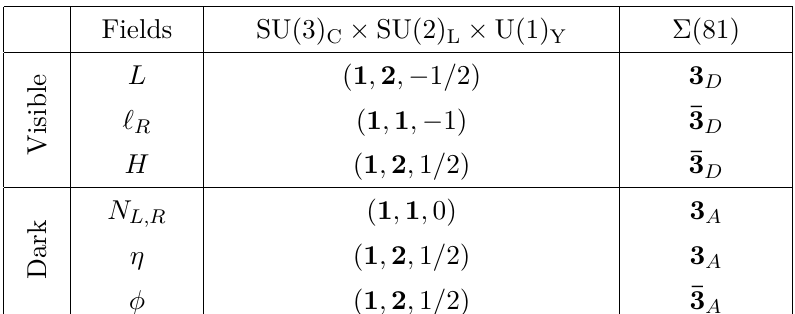
Table 1 . Particle content and symmetry transformation properties under the SM gauge group and the flavour symmetry Σ(81) . Note that the fields of the visible sector transform as 3 , while the dark sector transforms as 3 1 ( i,j ) automatically stable. See text for